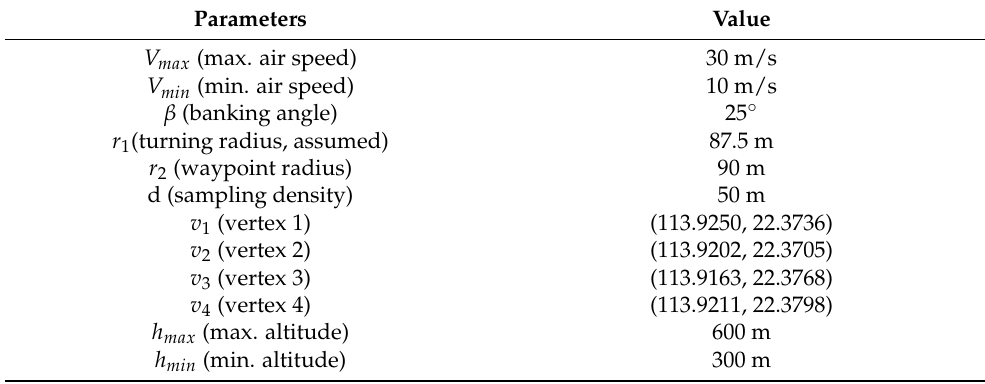
Table 2. Predefined parameters.